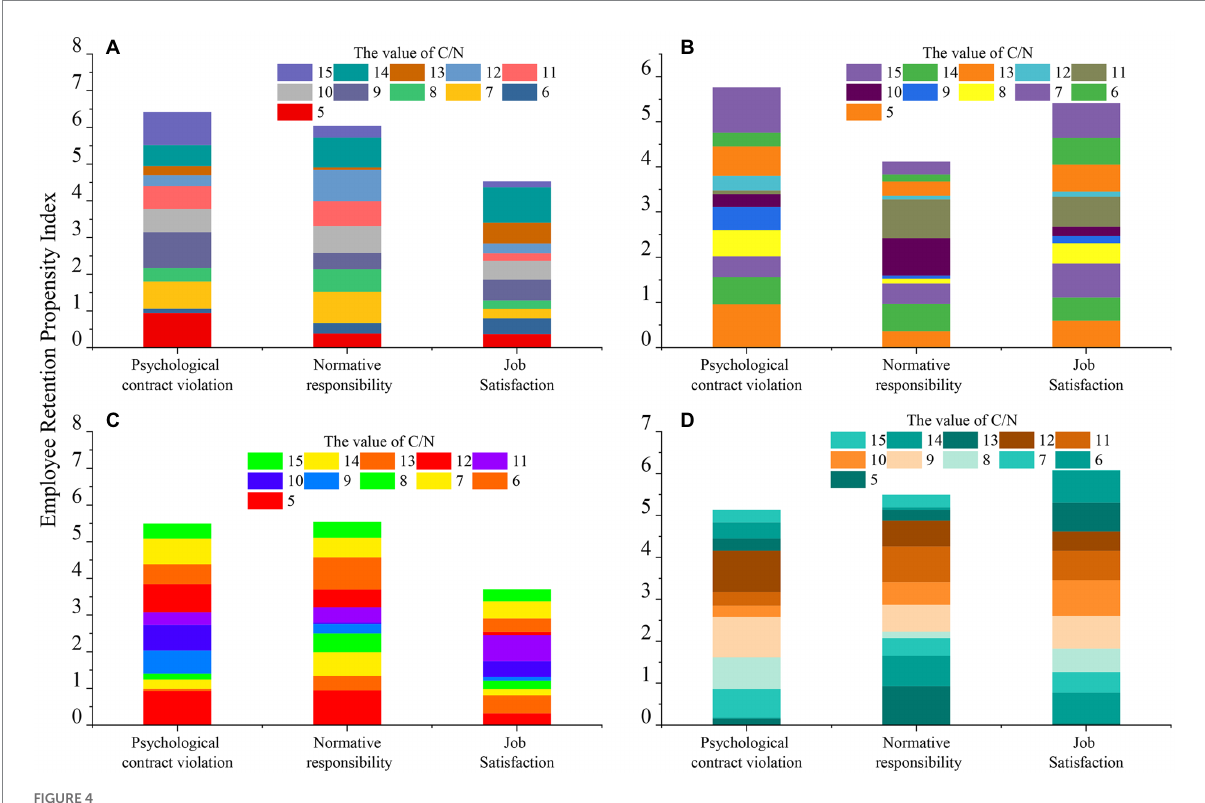
FIGURE 4 Manufacturing psychological factors and employee retention